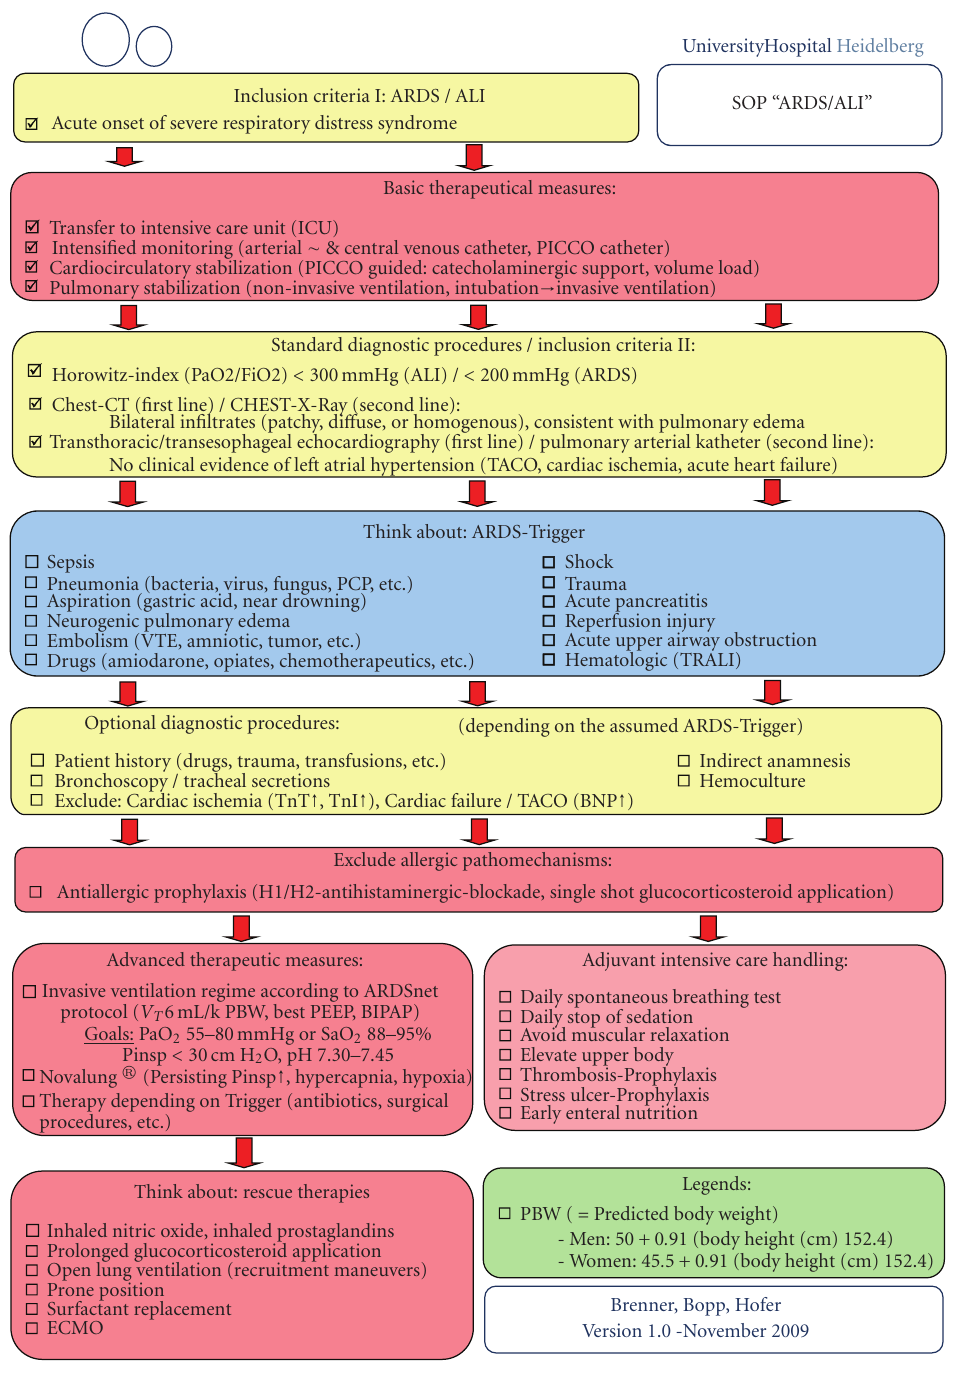
Figure 4: Standard operating procedure (SOP) of the Department of Anesthesiology, University of Heidelberg, Germany, for the diagnosis and management of patients with suspected